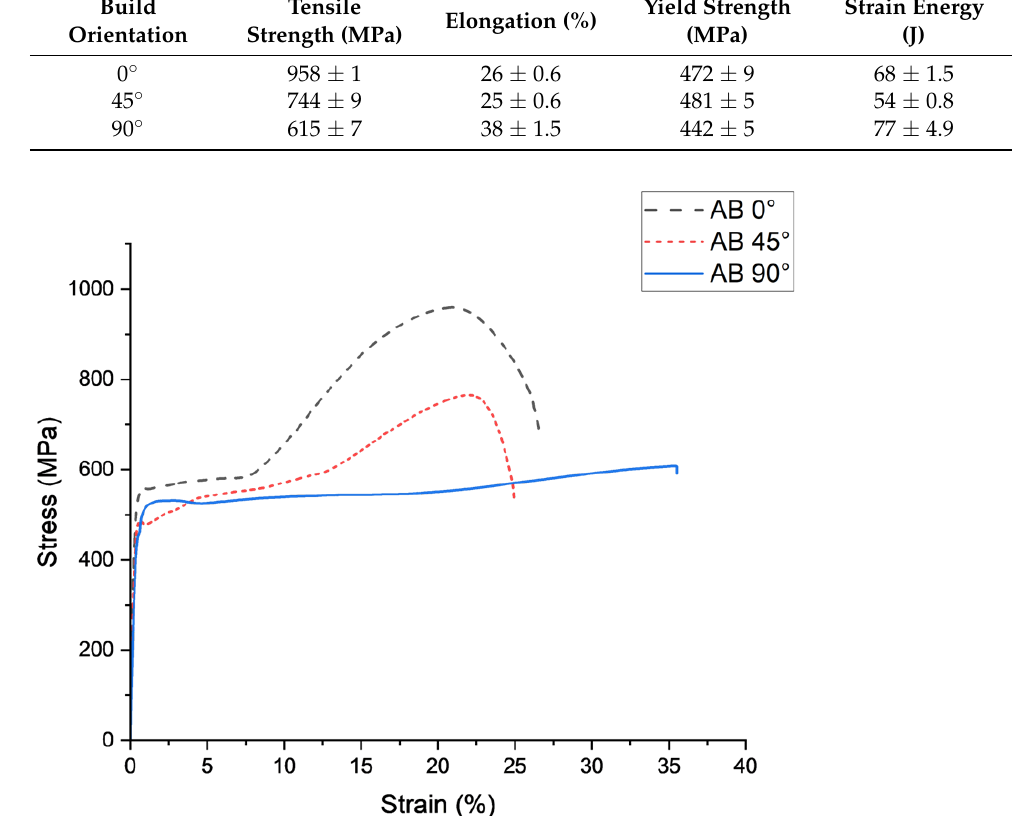
Figure 17. Stress strain curve for all build direction.